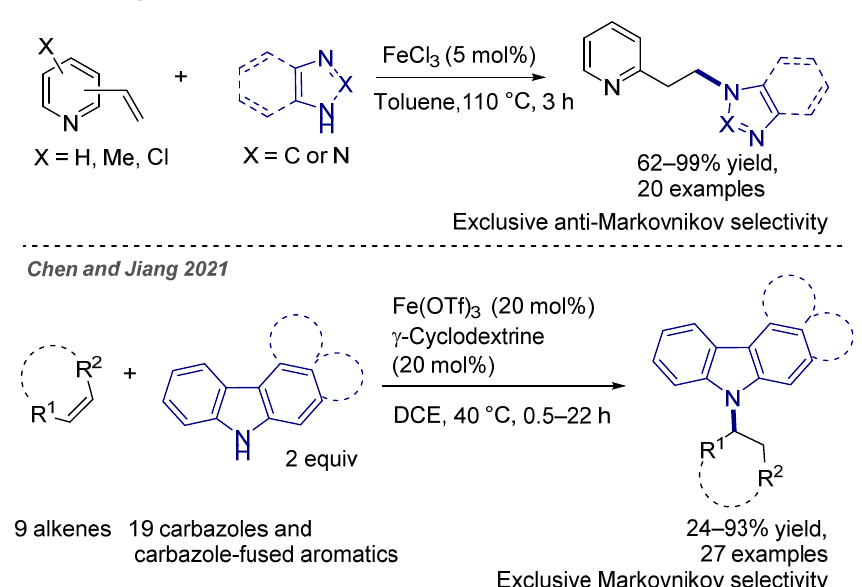
Figure 6. Selective intermolecular iron(III)-catalyzed alkene hydroamination with N -heterocycles. Last year, Chen, Jiang and co-workers published a general catalytic system, com- posed of Fe(OTf) 3 and -cyclodextrin, for the Markovnikov selective hydroamination of